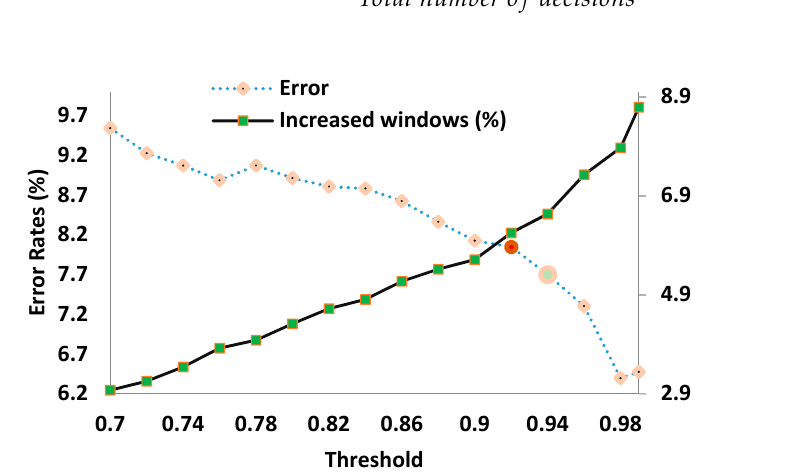
Figure 4. An example of the behaviour of the error of classification (on the validation set—see Table 2) and percentage of increased windows with the classifier trained with the training set and tested with the validation set for the case of 9-movement classes with 7 electromyogram (EMG) channels for amputee TR6 with TD-PSD feature extraction method. Primary axis is the error rates (dotted line) and secondary axis is the % of increased windows (solid line). The trade-off threshold is shown as a red circle.